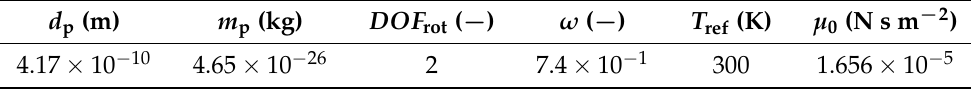
Table 1. Molecular properties of gaseous